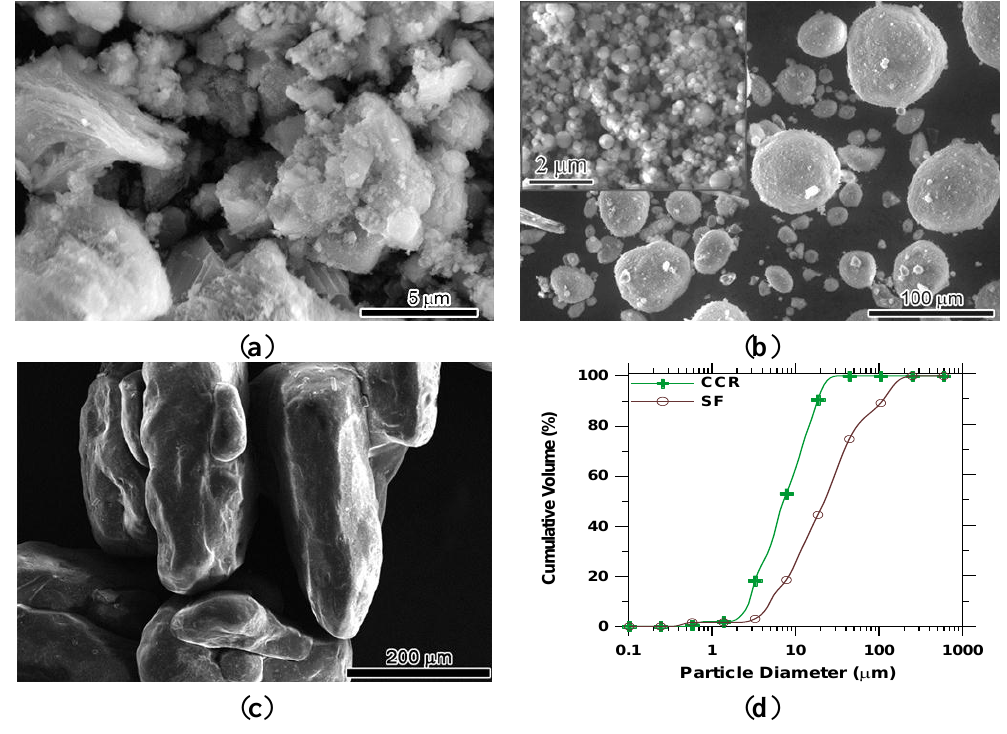
Figure 2. SEM images of CCR ( a ); SF ( b ); and urea ( c ); Particle size distribution of CCR and SF ( d ).